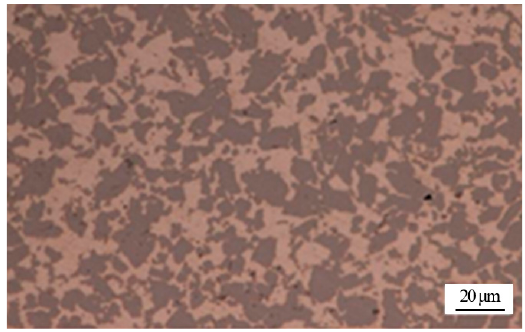
Figure 1. Microstructure of 50 wt.% Si p /Al MMCs manufactured by spray casting technique.